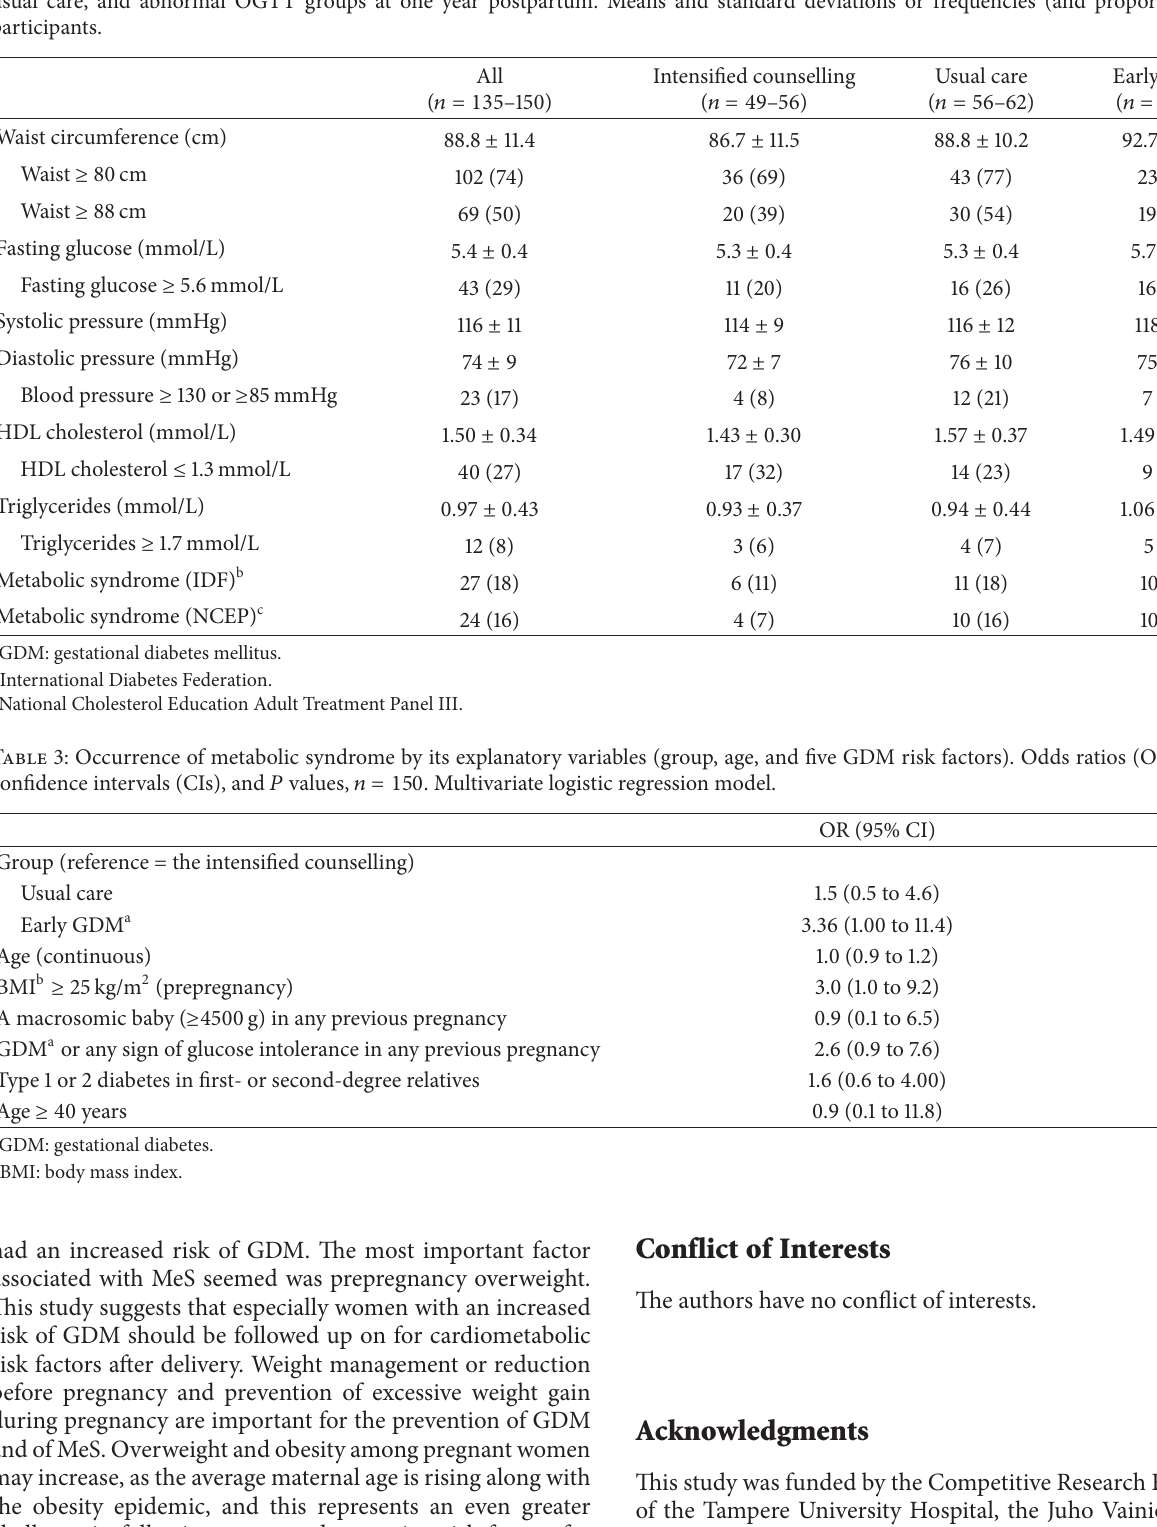
Table 2: Components of metabolic syndrome (MeS) and prevalence of MeS by two criteria in all women and in the intensified counselling, usual care, and abnormal OGTT groups at one year postpartum. Means and standard deviations or frequencies (and proportions) of participants.